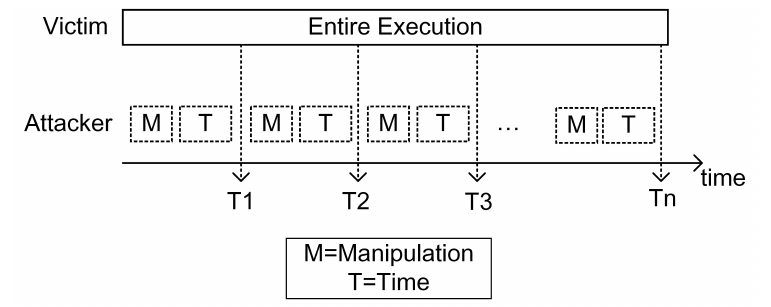
Figure 1. Process of trace-driven